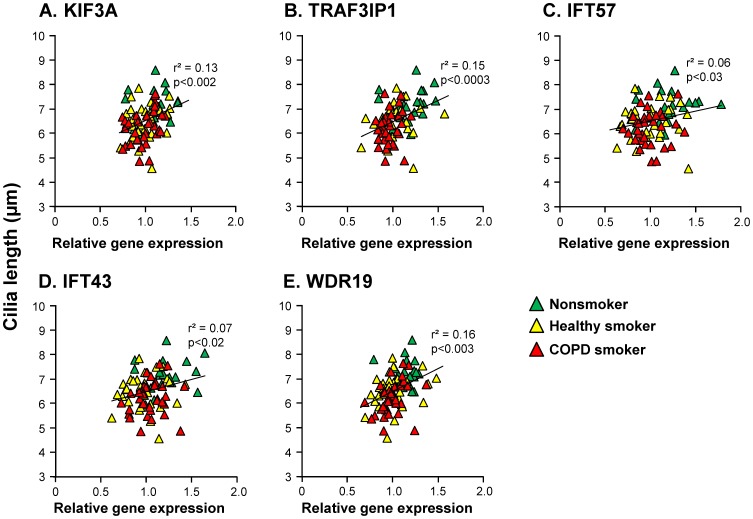
Correlation of cilia length with gene expression in the small airway epithelium.The ordinate represents mean cilia length for each individual and the abscissa represents relative gene expression. Each individual is represented by a triangle with nonsmokers represented by green triangles, healthy smokers by yellow triangles, and COPD smokers by red triangles. A. Correlation of cilia length with KIF3A expression. B. Correlation of cilia length with TRAF3IP1 expression. C. Correlation of cilia length with IFT57 expression. D. Correlation of cilia length with IFT43 expression. E. Correlation of cilia length with WDR19 expression.